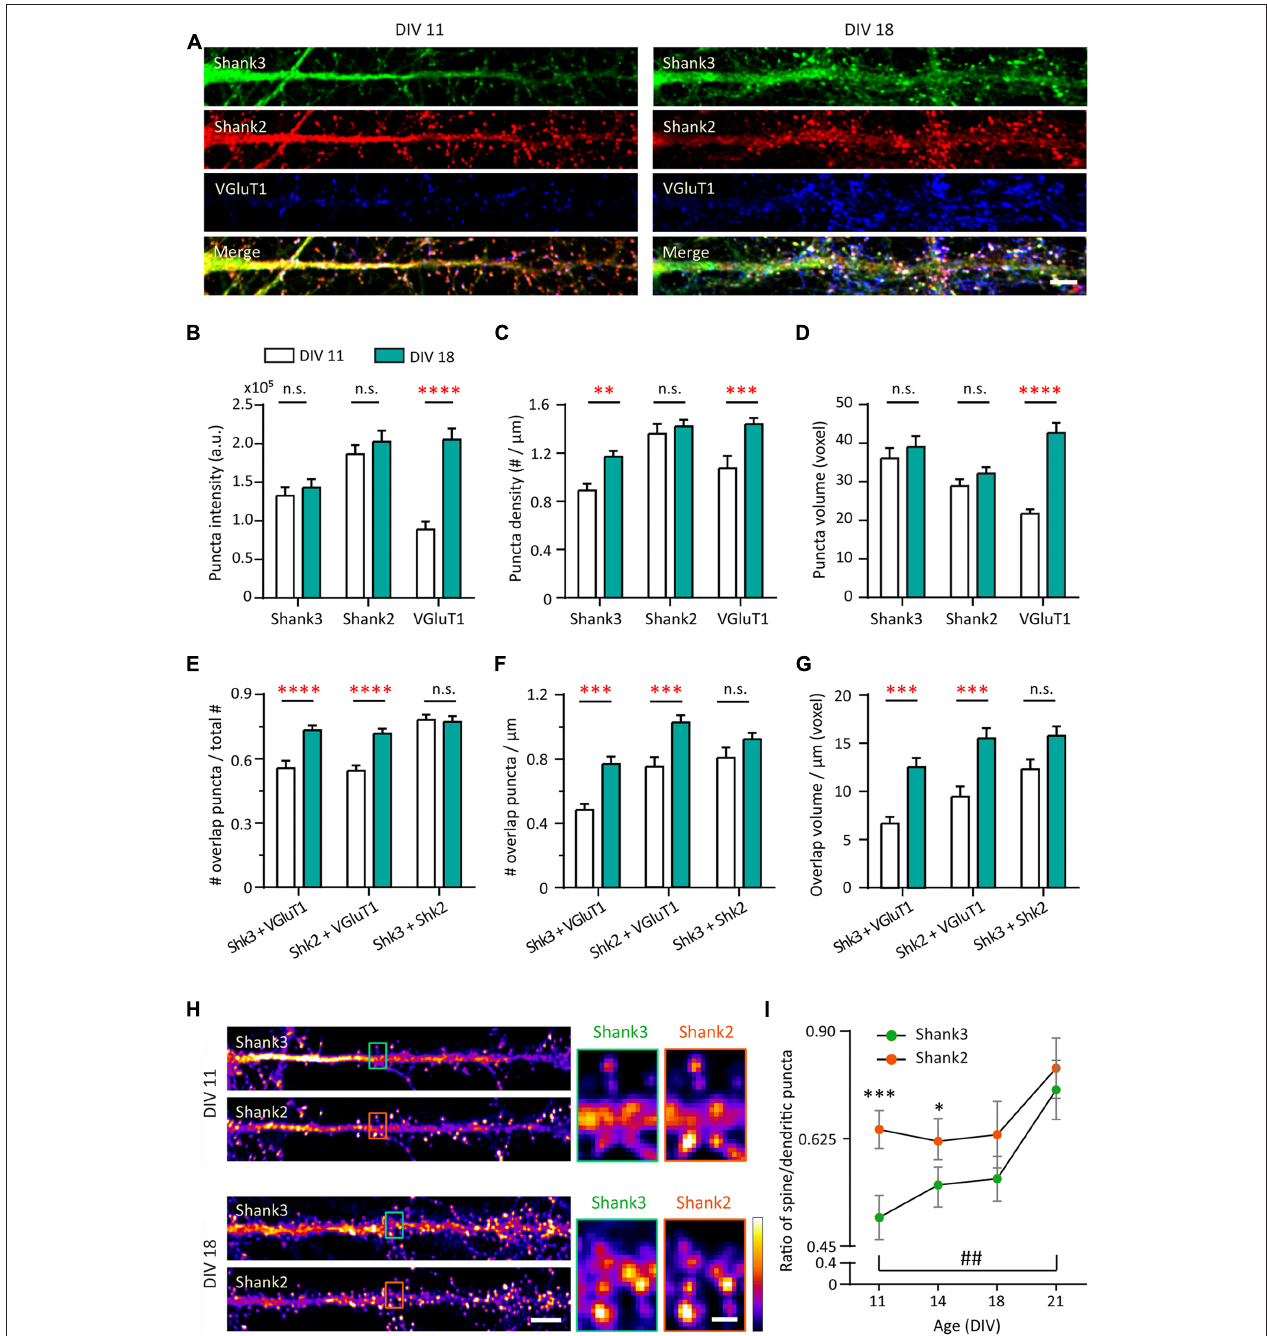
FIGURE 1 | Increase in synaptic expression of Shank2, Shank3 and VGluT1 during development. (A) Straightened dendrites of young (days in vitro 11, DIV 11) and mature (DIV 18) hippocampal neurons co-immunostained for Shank3 (A488, green), Shank2 (A568, red) and VGluT1 (A647, blue). White puncta in the merge images (bottom) indicate colocalization of all three proteins. Scale bar: 5 µ m. (B–D) Three-dimensional analysis (IMFLAN3D) of Shank3 and Shank2 puncta at DIV 11 and 18 quantifying intensity (B) , density (C) or volume (D) (mean ± SEM). (E–G) Three-dimensional colocalization analysis of pairwise puncta overlap as measured by the ratio (E) , density (F) and volume (G) at DIV 11 and 18 [mean ± SEM; N = 16 dendrites from 10 to 12 neurons from two culture preparations (referred to as culture preps from now on; Mann-Whitney tests. n.s. p ≥ 0.05, ∗∗ p < 0.005, ∗∗∗ p < 0.0005, ∗∗∗∗ p < 0.0001)]. (H) Straightened dendrites of young and mature hippocampal neurons immunostained for Shank3 and Shank2. Scale bar: Image, 5 µ m; Corresponding inset, 1 µ m. (I) Summary graphs showing quantification of Shank3 and Shank2 relative enrichment in spines vs. in dendritic puncta (DIV 21, N = 18; all others, N = 16 dendrites from 10 to 12 neurons from two cultures preps; Kruskal-Wallis one-way analysis of variance (ANOVA) followed by Dunn’s correction post hoc multiple comparisons. Comparing between Shank2 and Shank3 at the same age: ∗ p < 0.05; ∗∗∗ p < 0.0005. Comparing Shank3 between different ages: ## p < 0.005).